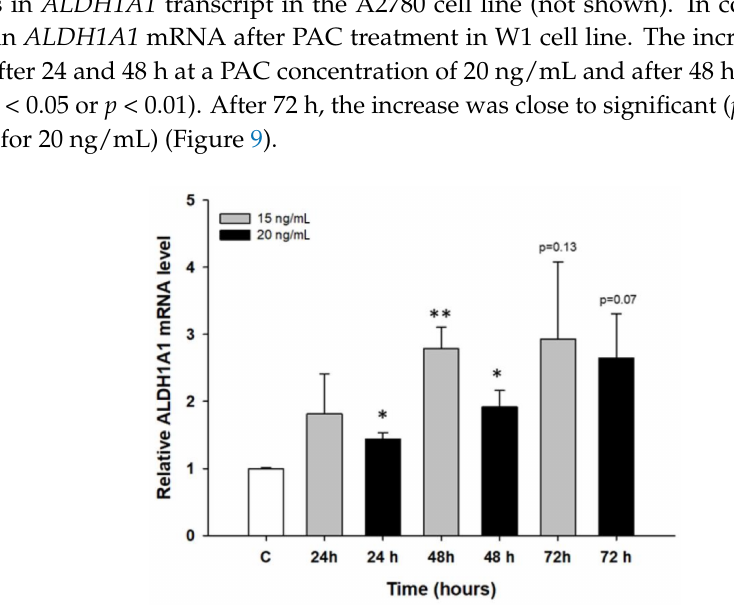
Figure 9. Expression analysis of the ALDH1A1 gene in the W1 cell line. The figure presents the relative gene expression in the PAC-treated cells (grey and black bars) with respect to that of the untreated control (white bars), which was assigned a value of 1. The values were considered significant at * p < 0.05 and ** p <